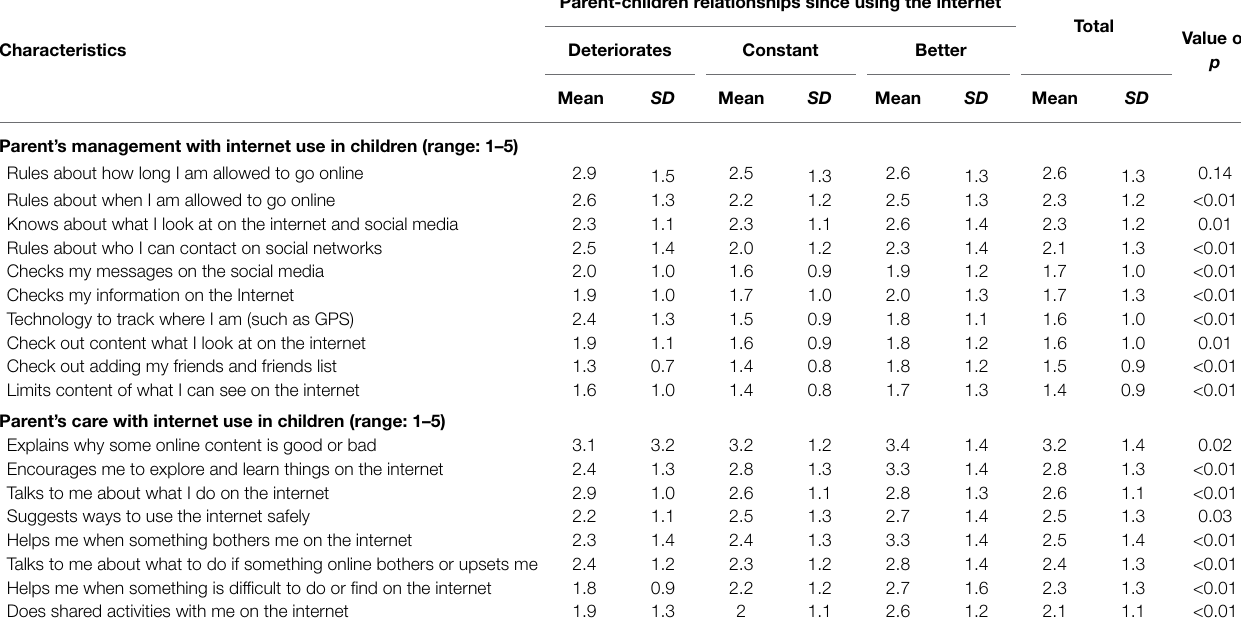
TABLE 3 | The parent’s management and care with internet use in their children.